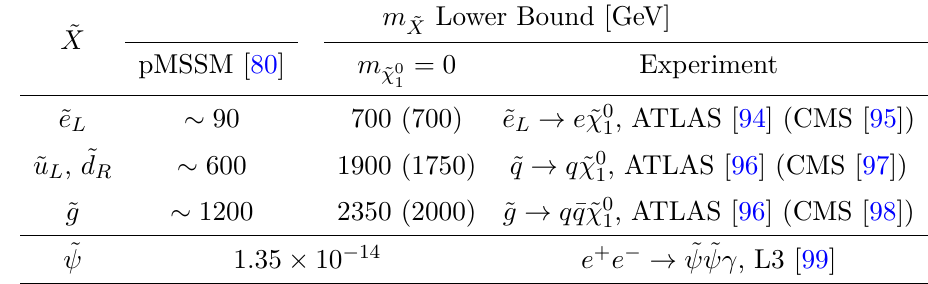
Table 1 . Lower limits on the masses of the superpartners relevant to 0 νββ decay when an RPV coupling λ 0 is present, approximately in the pMSSM by excluding 90% of models, and from 111 searches for superpartners decaying to a massless (purely bino) neutralino with 100% branching ratio at ATLAS and CMS. Also shown is the lower bound on the gravitino ˜ ψ mass from L3. even for λ 0 6 = 0 , which is justified if λ 0 is small. The bounds weaken considerably for 111 111 larger m , and often a different decay mode provides a more stringent lower ˜ χ 0 1